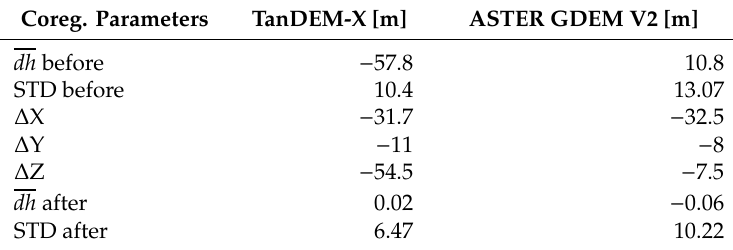
Table 3. Co-registration details for the TanDEM-X and ASTER GDEM V2 relative to the reference DEM derived from stable terrain before and after the co-registration. The variables ∆ X, ∆ Y and ∆ Z are the shift vectors, STD is the standard deviation and dh is the mean di ff